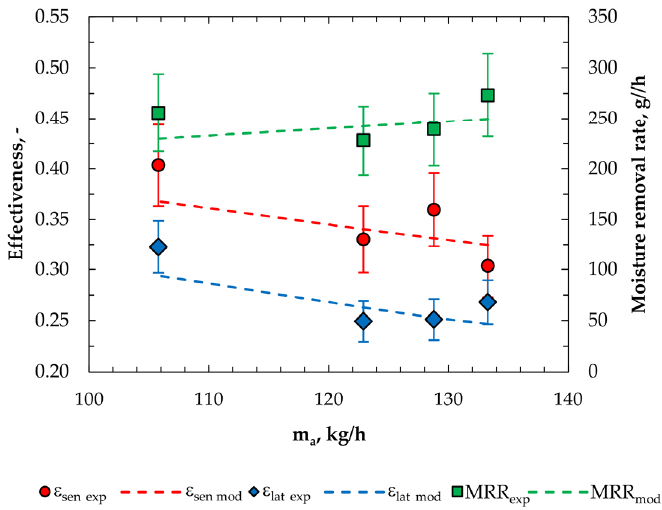
Figure 4. Comparison of experimental and modeling performance indices of the module for air flow rate (m s = 61 kg/h, X = 34.3%).